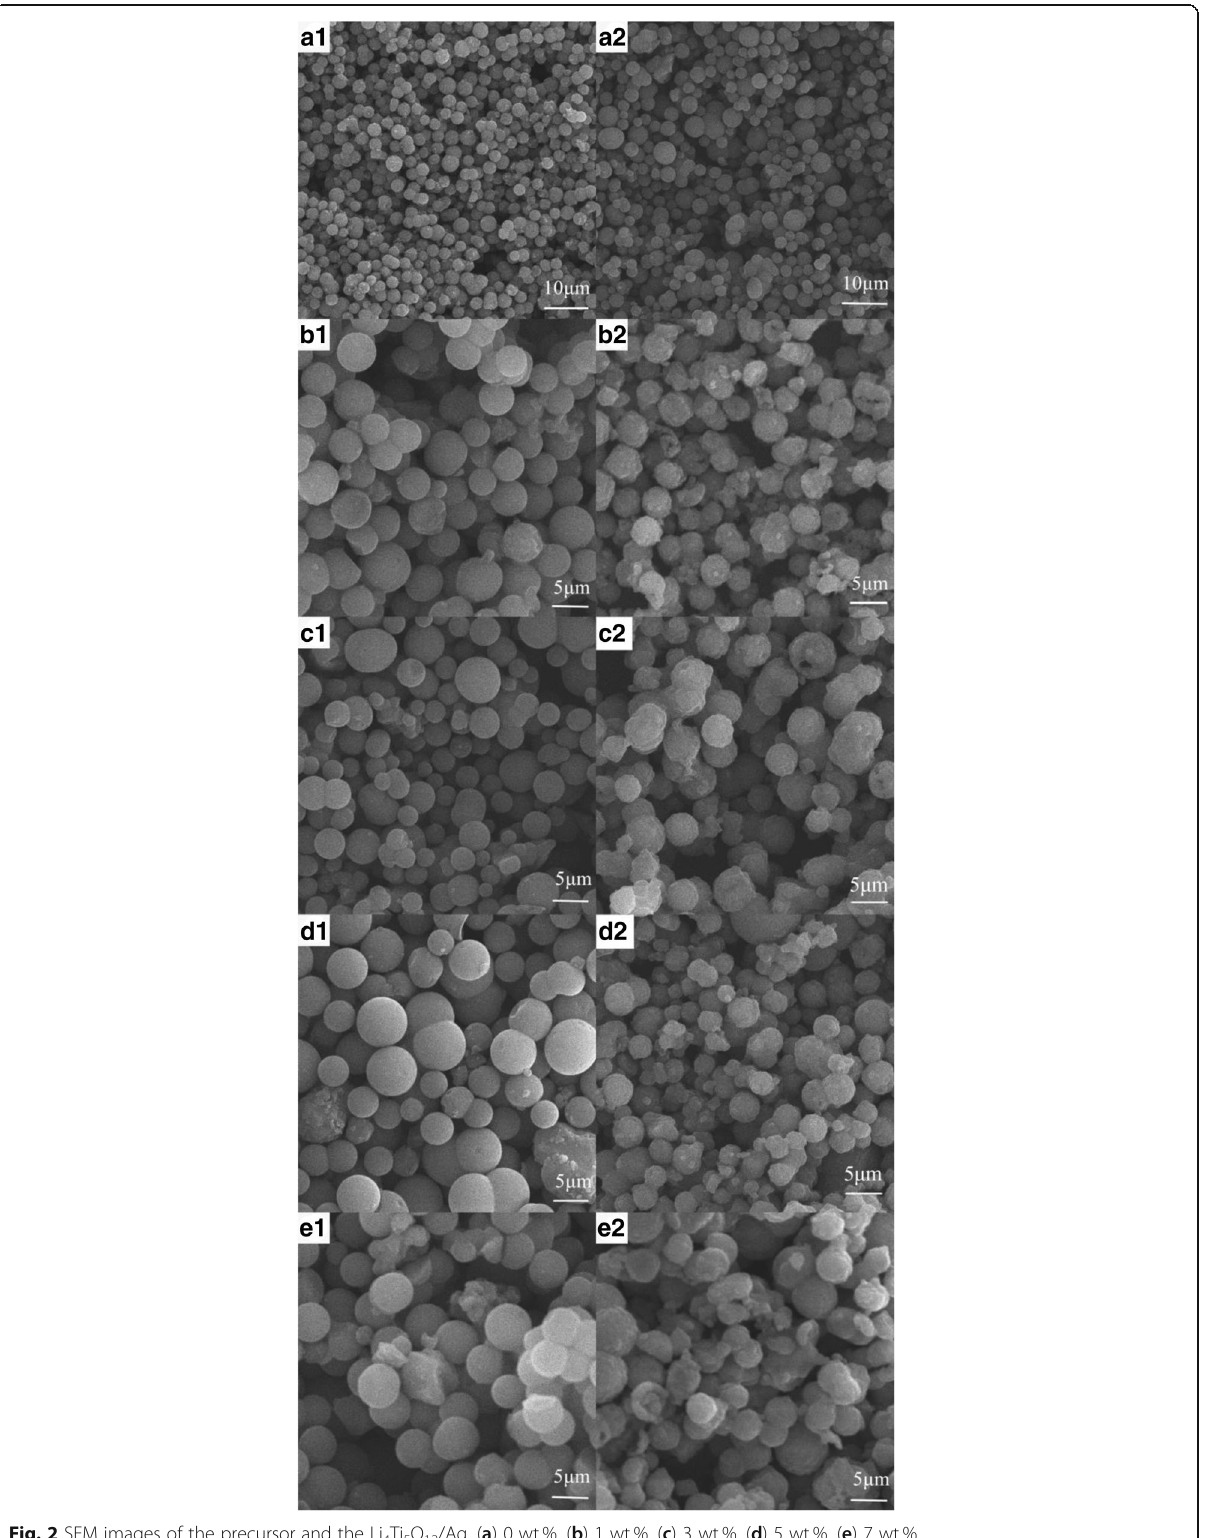
Fig. 2 SEM images of the precursor and the Li 4 Ti 5 O 12 /Ag. ( a ) 0 wt.%, ( b ) 1 wt.%, ( c ) 3 wt.%, ( d ) 5 wt.%, ( e ) 7